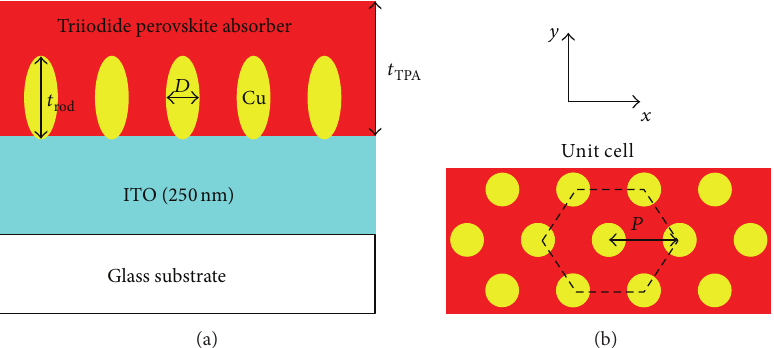
Figure 3: (a) Side view of TPA/ITO/glass with the Cu nanoplasmonic structure. (b) Top view of the Cu nanoplasmonic structure embedded in the TPA thin